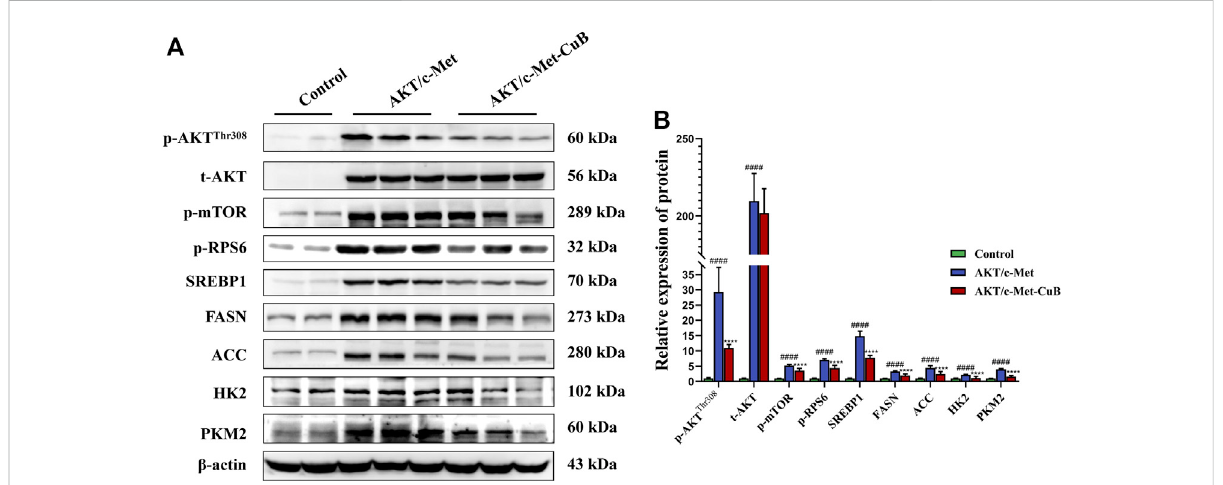
FIGURE 6 CuB inhibitsthe AKT/mTORC1 signal pathway in AKT/c-Met mice. (A) Western blotting analysis for different proteins; (B) Histograms depict the levels of protein expression. As an internal reference, β -actin was used as the housekeeping gene ( #### p < 0.0001 vs. Control group; **** p < 0.0001 vs. AKT/c-Met group; quantitative data are the mean ± S.D. of the density values from the Western blotting experiment, n = 3, pounds and asterisks indicate statistical signi fi cance as determined by two-tailed unpaired t -test comparisons with two